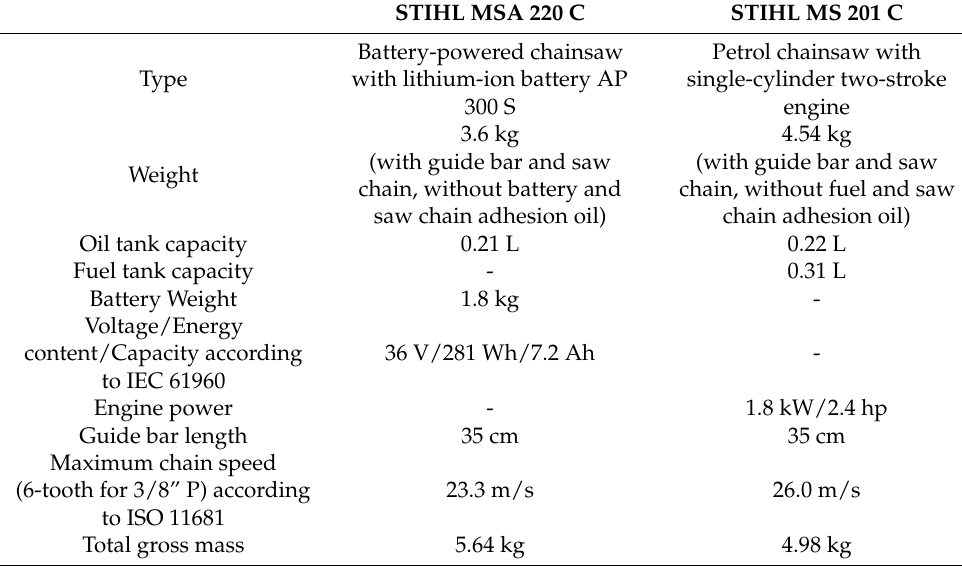
Table 1. Specifications stated by the manufacturer of the STIHL MSA 220 C and its